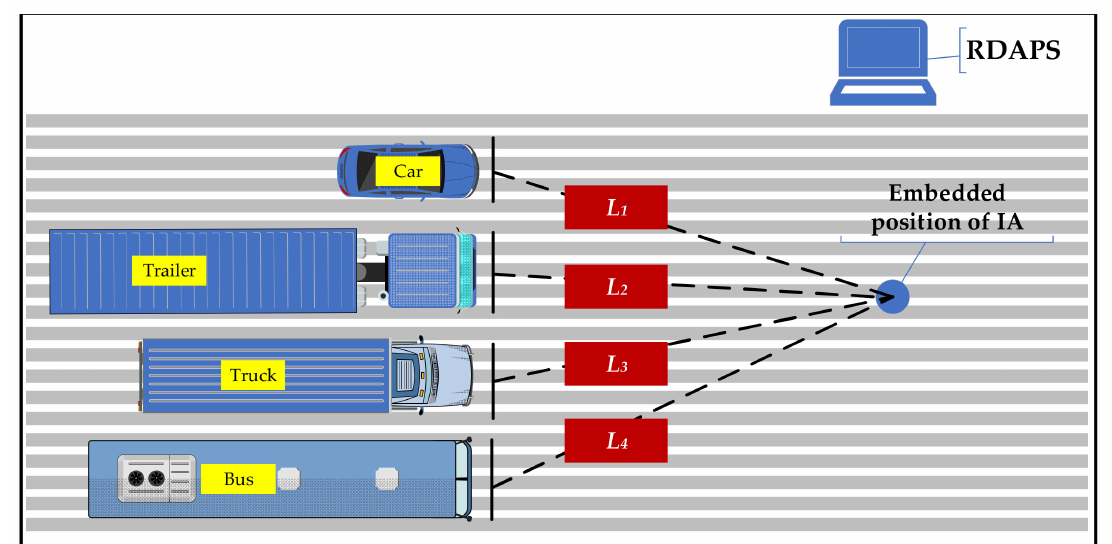
Figure 7. Test scheme for the disturbance characteristics for an IA.